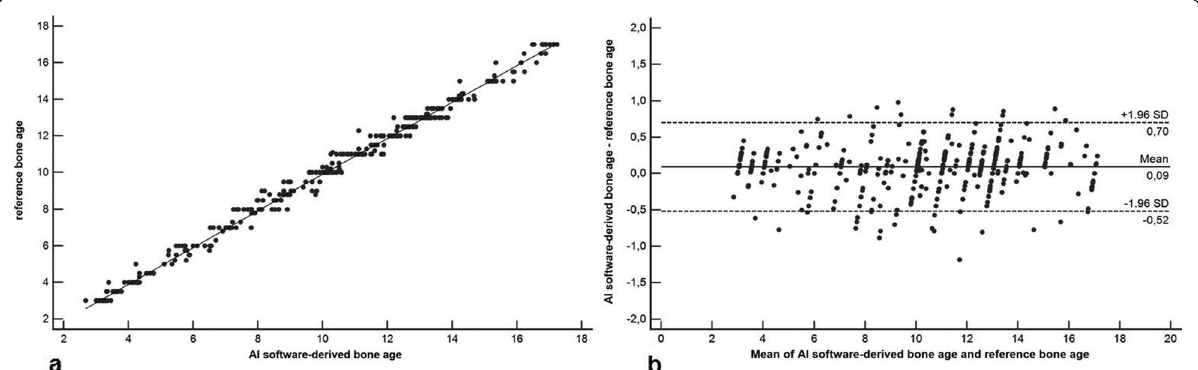
Fig. 3 Correlation and agreement analysis of BoneXpert version 2.1-derived BA values and the reference values. a Pearson product-moment correlation shows excellent correlation with r = 0.988, 95% confidence interval (CI) 0.971 – 0.998, and r 2 = 0.976, 95% CI 0.951 – 0.992. b Bland-Altman plot demonstrates excellent agreement between BA values of both approaches. Values are given in years. AI Artificial intelligence, BA Bone